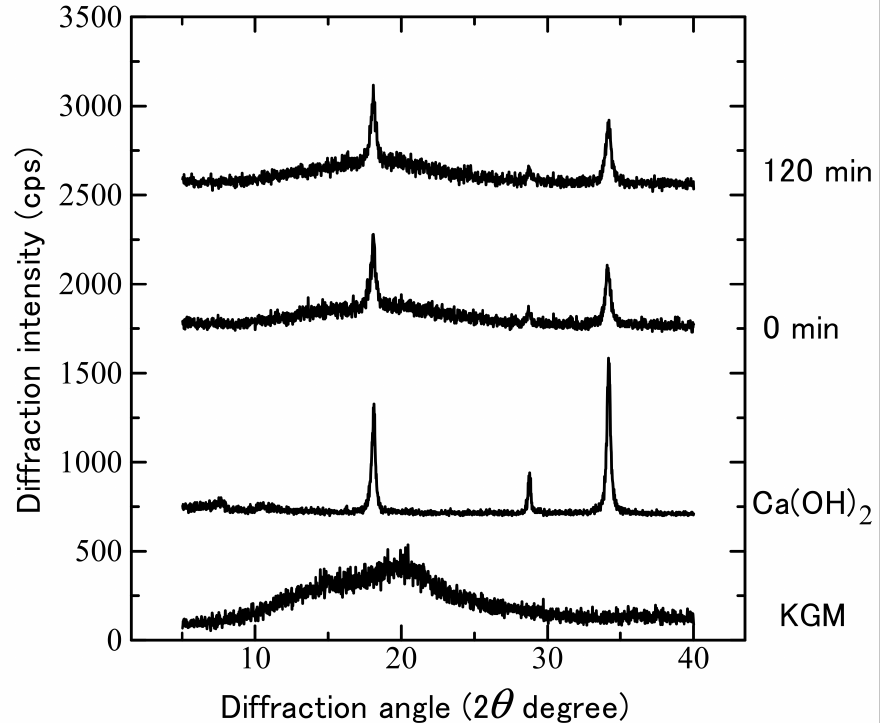
Figure 1. Powder X-ray diffraction profiles of the KGM mixtures containing 16.0 w/w % Ca(OH) 2 after various grinding times.